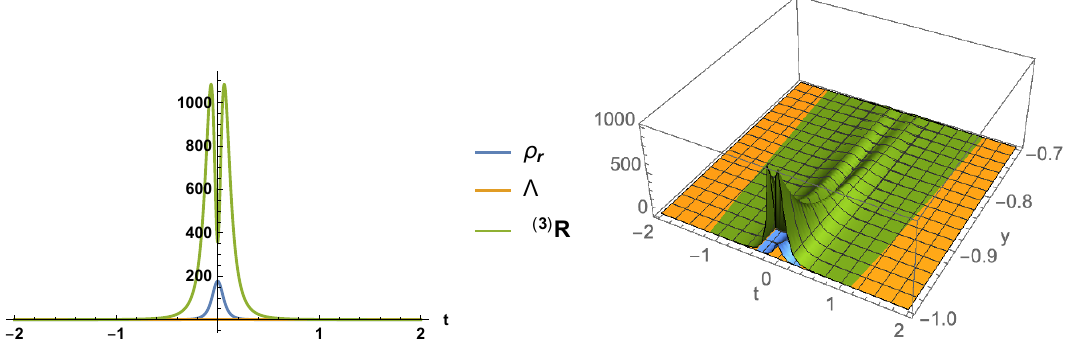
Figure 4 . An example with large spatial curvature. In blue is shown the energy density of the electromagnetic field, in orange that of the cosmological constant (equal to Λ = 1), while the green curve/surface shows the 3-curvature. The parameter values are σ = 8 , α = 9 / 10 , q 1 = 1 / 20 , q 2 = 0 . Left panel: y = 1 . Right panel: 1 0 . y − − ≤ ≤ −